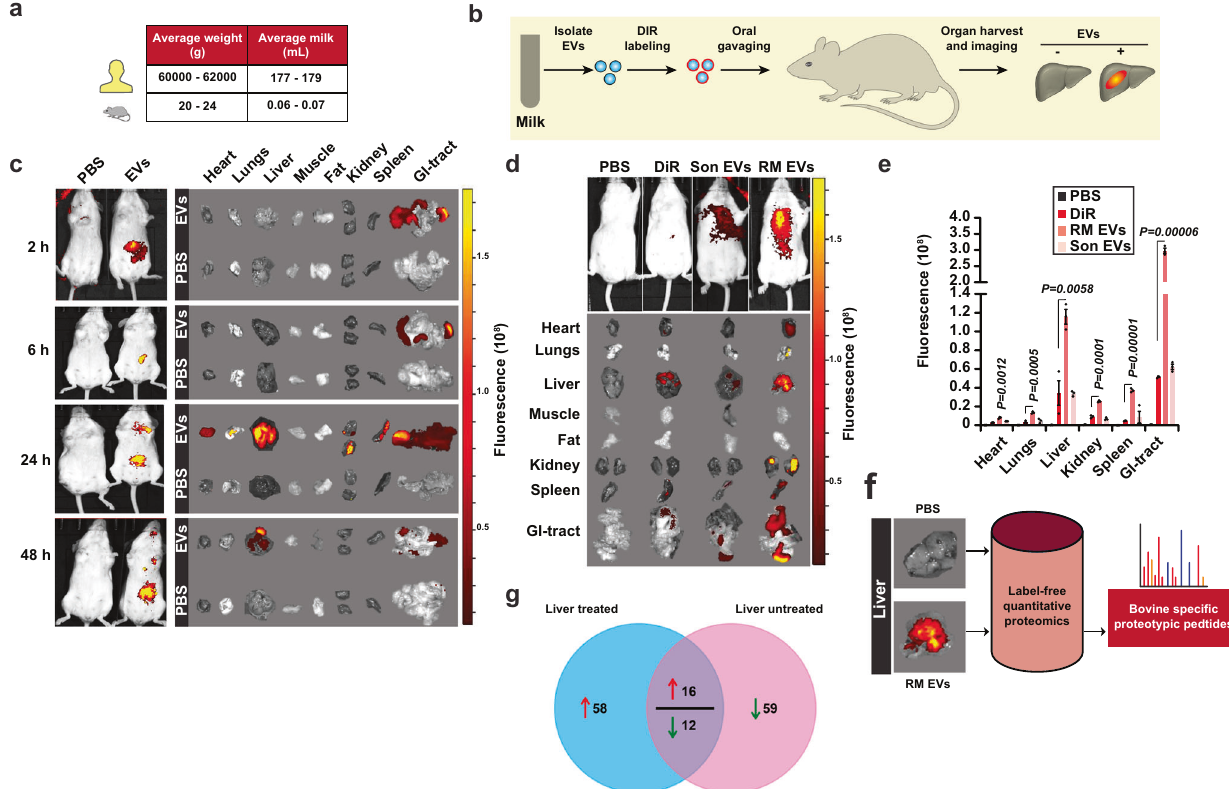
Fig. 2 Biodistribution of orally administered bovine milk-derived EVs. a Schematic representation of dosage of milk-derived EVs and its physiologically relevant concentration in human and mice normalized to the body weight. b Schematic diagram of in vivo imaging of milk-derived EVs. c Female BALB/c mice were administered a single dose of 25 mg/kg DiR-labeled EVs by gavage (p.o.) and in vivo imaging of the mice after 2, 6, 24, and 48 h of EV administration were performed using IVIS Lumina XR-III ( n = 4 ). d Balb/c mice were orally gavaged ( p.o .) with a single dose of DiR-labeled EVs (RM EVs) (25 mg/kg), sonicated DiR-labeled EVs (Son EVs), free DiR and PBS. After 24 h, ex vivo imaging of the tissues was performed using the In vivo imaging system (IVIS). e Quanti fi cation of fl uorescence in mice organs ( n = 3). f Schematic representation of quantitative proteomics analysis to identify bovine proteotypic peptides in mouse liver tissues. g Venn diagram of differentially abundant proteins in mouse liver tissue of RM EVs and PBS administered mice. The red arrow represents proteins that are of high abundance in liver tissue of RM EVs treated mice compared to PBS administered mice. The green arrow represents proteins that are of lower abundance in liver tissue of RM EVs treated mice compared to PBS administered mice. All data are represented as mean ± s.e.m. Statistical signi fi cance was determined by unpaired two-tailed t